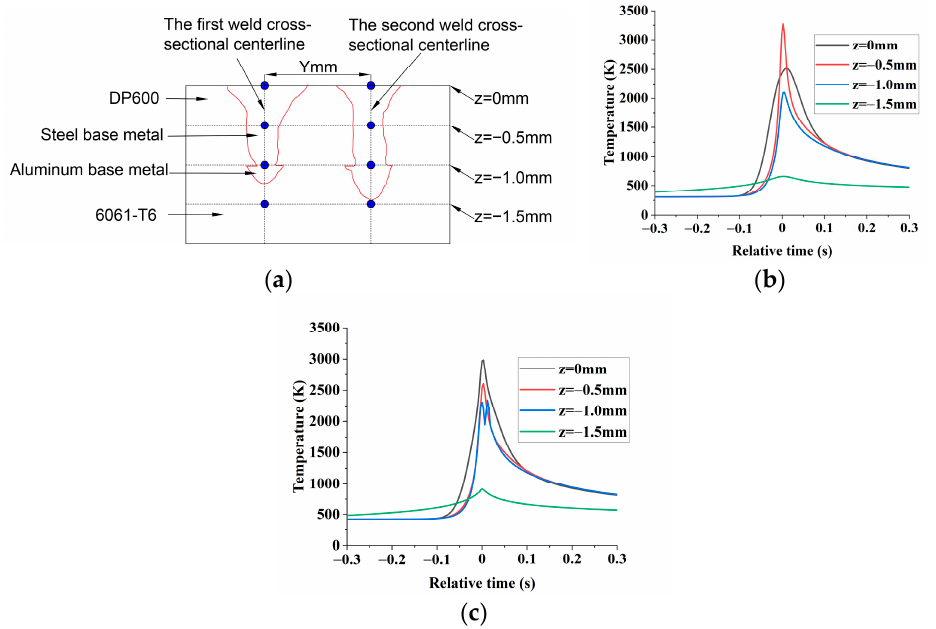
Figure 7. Time − temperature history of monitoring points from weldment cross-section. ( a ) Location of temperature monitoring points of weld cross-section; ( b ) time-temperature diagram of monitoring points of the first weld; ( c ) time-temperature diagram of the monitoring point of the second weld with weld spacing of 1.5 mm.